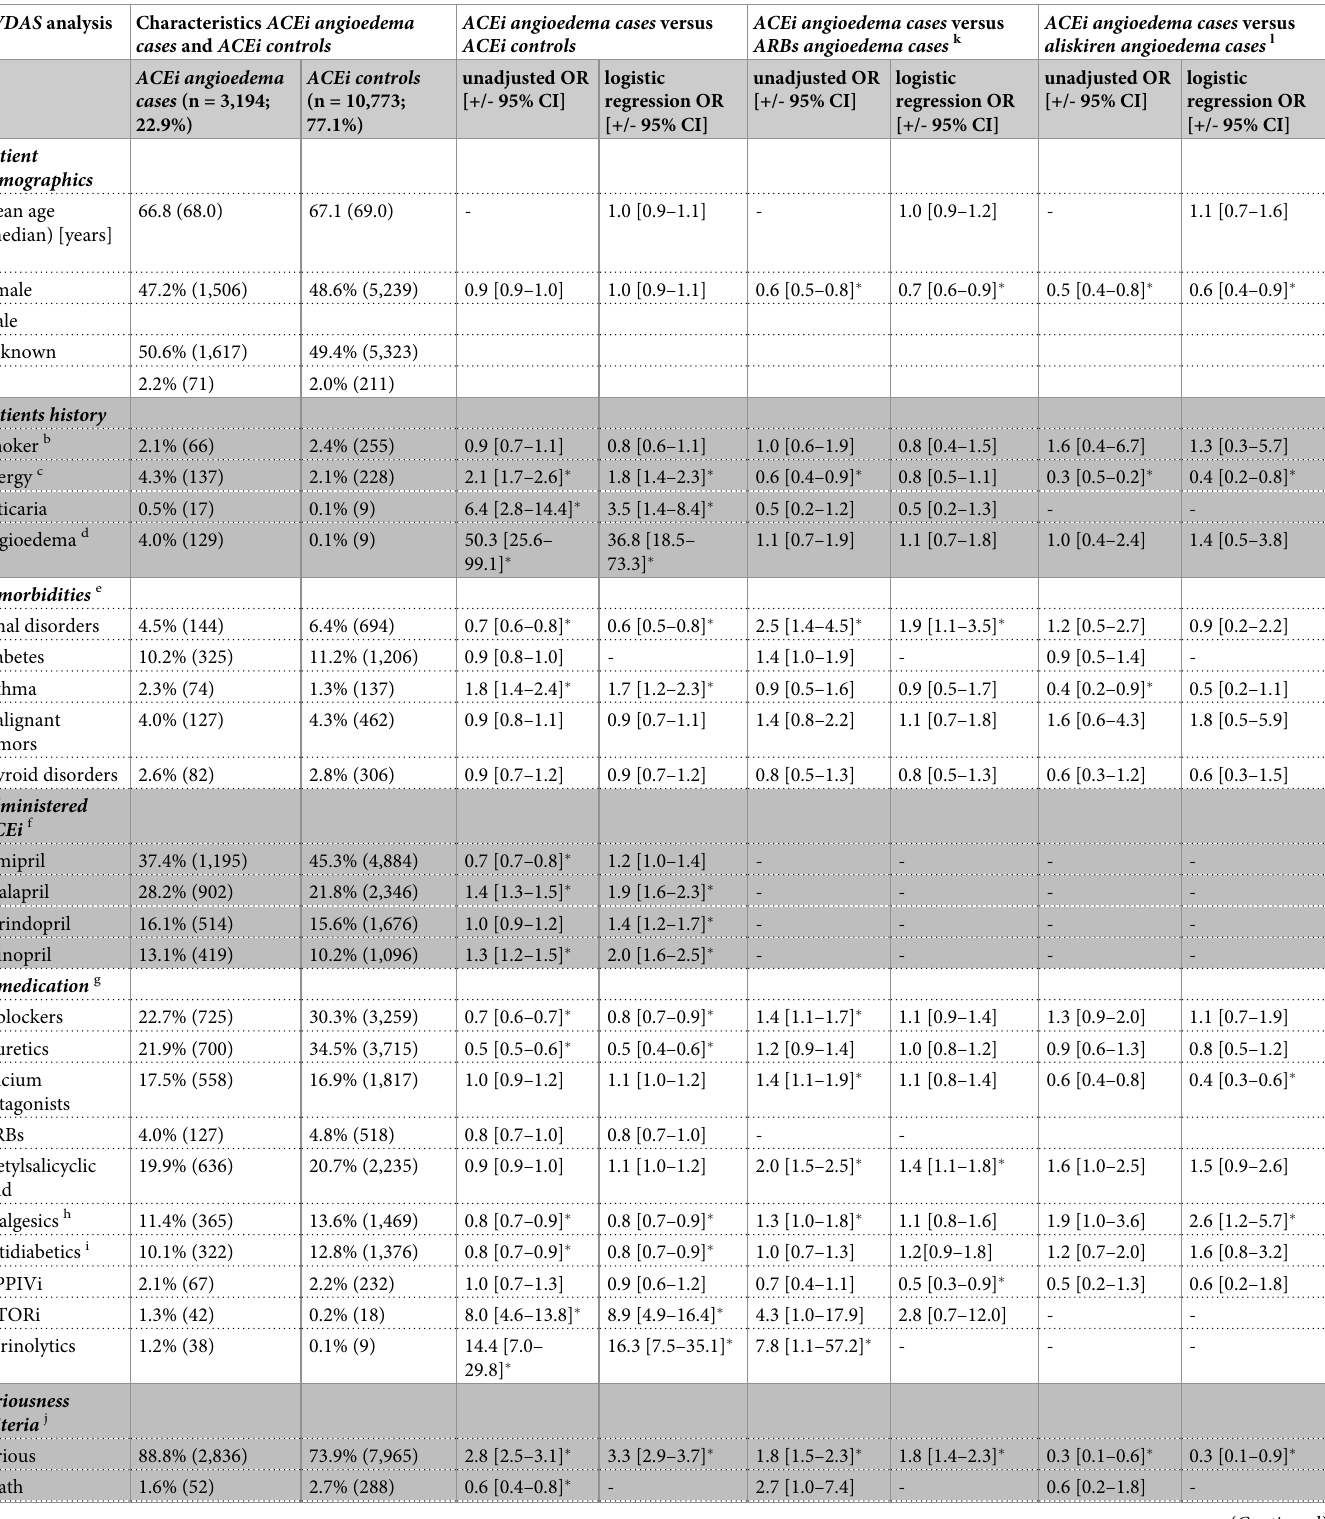
Table 1. EVDAS analysis: Reported characteristics in ACEi angioedema cases and ACEi controls and comparative analysis of ACEi angioedema cases versus ARBs and aliskiren angioedema cases . EVDAS analysis Characteristics ACEi angioedema cases and ACEi